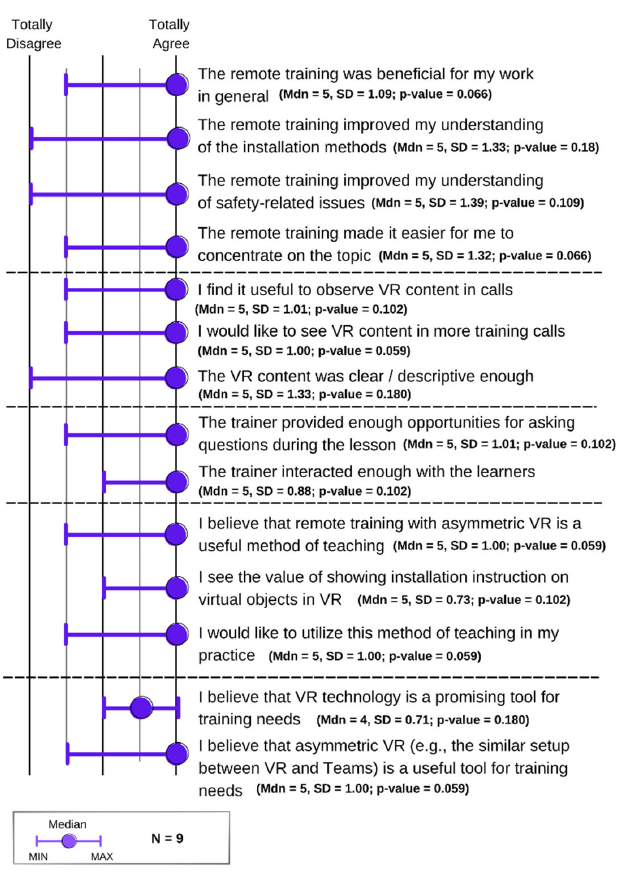
Figure 7. Descriptive statistics of the survey data, presented on a 5 ‐ point Likert scale.